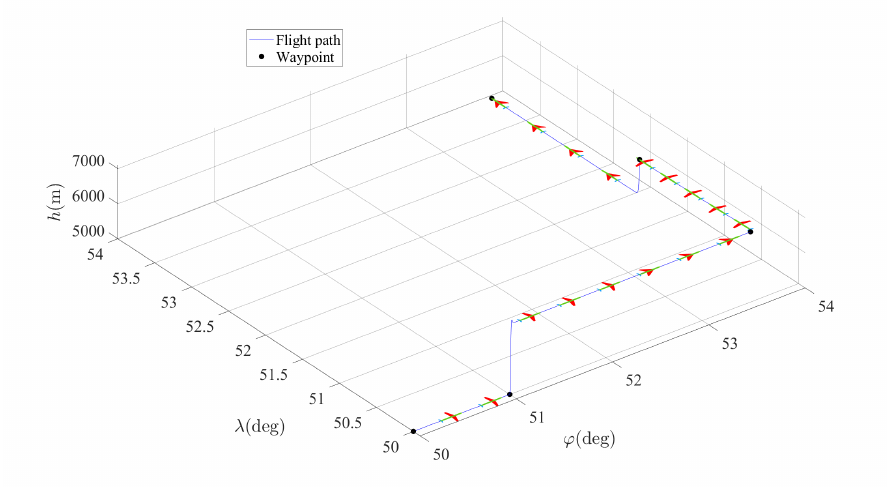
Figure 12. Flight path of the morphing aircraft with proposed morphing strategy in Section